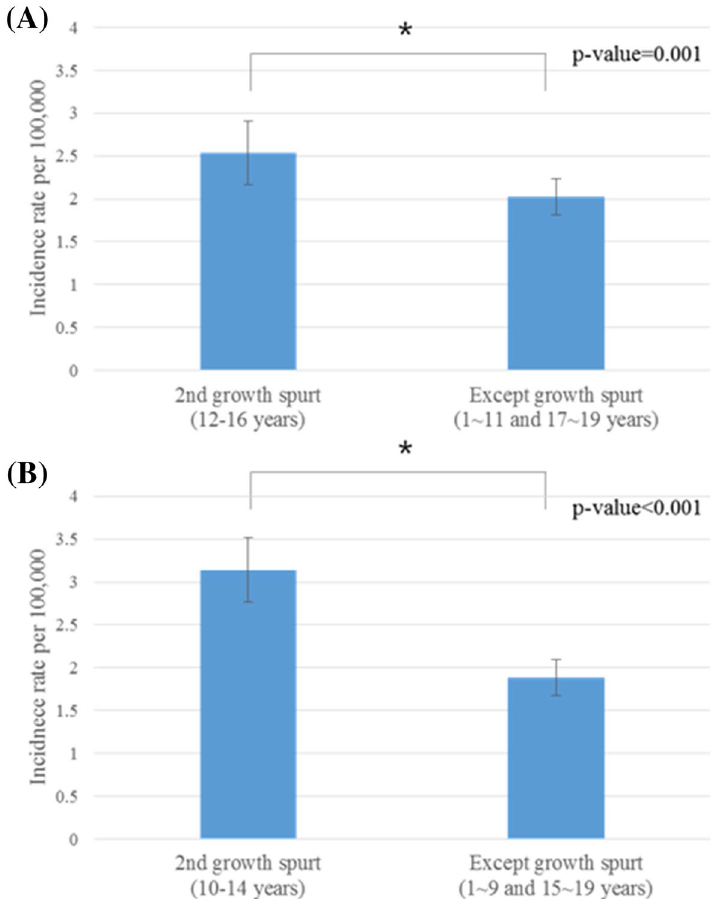
age in years, Y-axis; incidence rate per 100,000. 95% confidence intervals are also indicated. * means that the two groups are statistically significantly